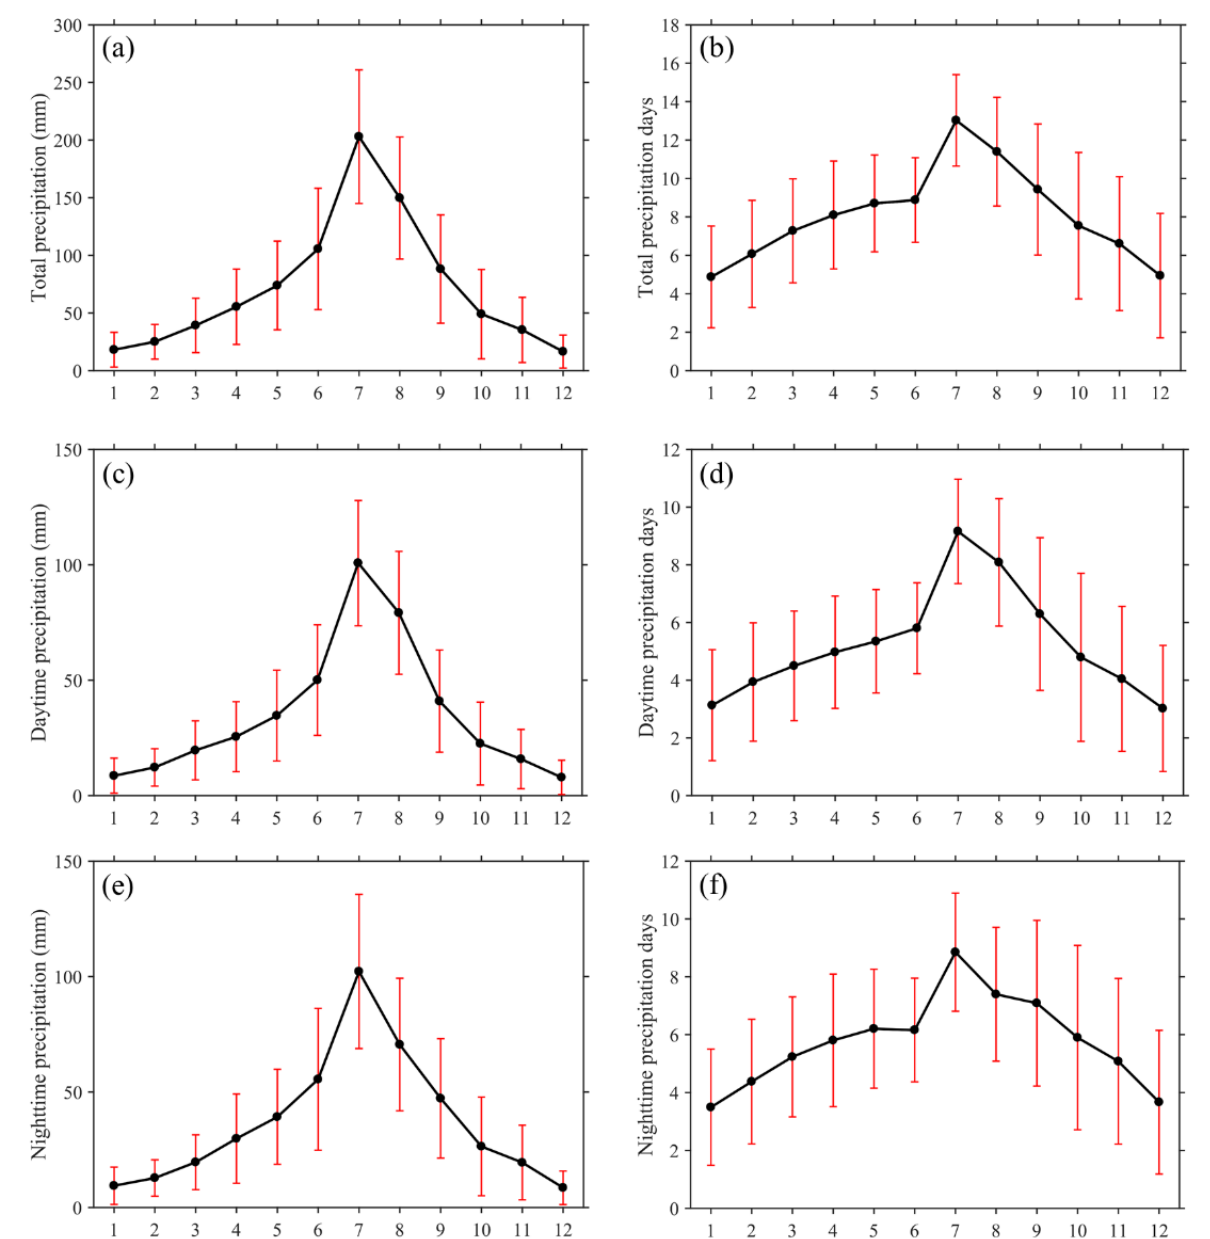
Figure 5. Climatology of monthly mean ( a , b ) total daily, ( c , d ) daytime, and ( e , f ) nighttime precipitation amount and days over the HRB from 1961 to 2018. Error bars (red line) represent ±1 standard deviation of the mean precipitation in each month.